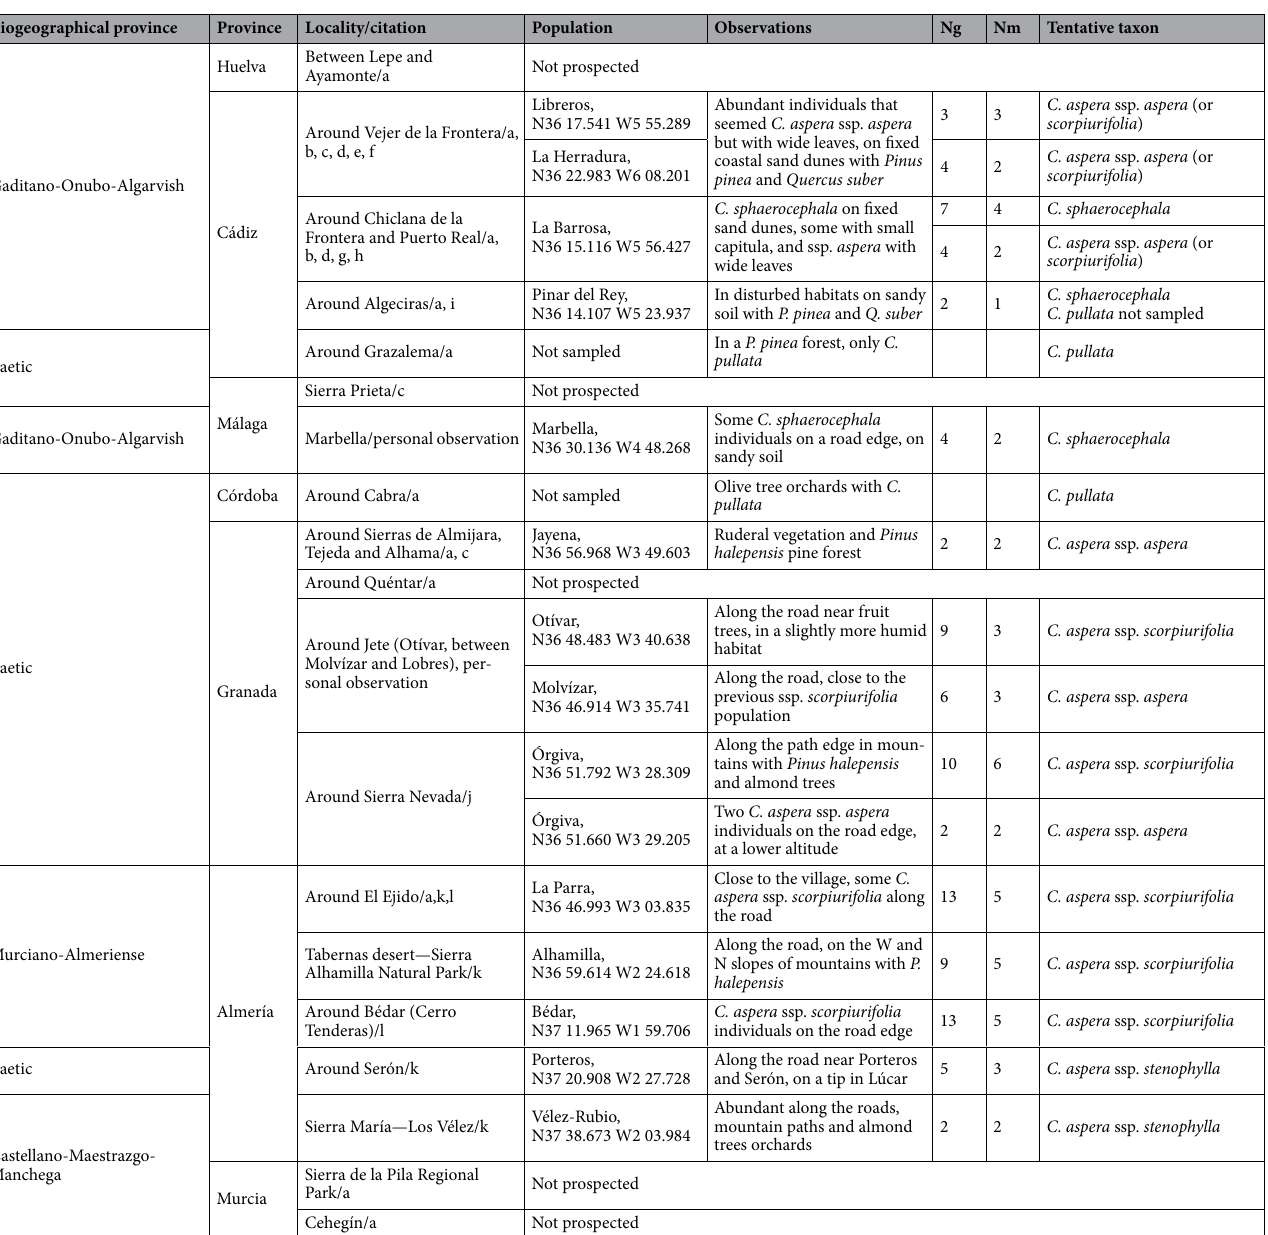
Table 1. Origin of the sampled Centaurea populations in Andalusia. The field trip was based on the citations of the localities (a 25 ; b 58 ; c 59 ; d 20 ; e 60 ; f 61 ; g 62 ; h 63 ; i 26 ; j 22 ; k 23 , l 24 . Geographic position, number of sampled individuals for genetic analyses (Ng) and for morphologic analyses (Nm), and the tentative taxon to which the individuals belong are